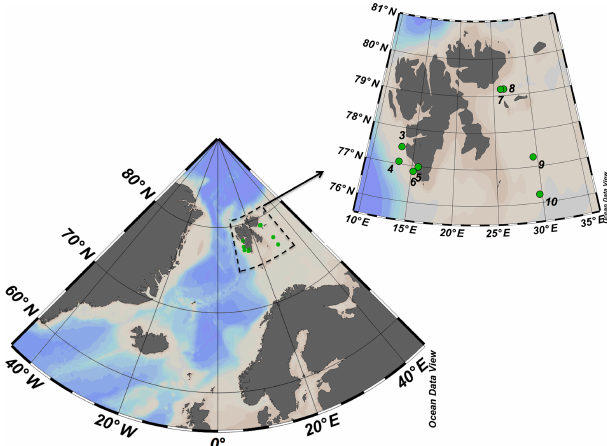
Figure 1. ARCEx cruise study area with the insert showing the sta- tion number and location (green dots) around the Svalbard